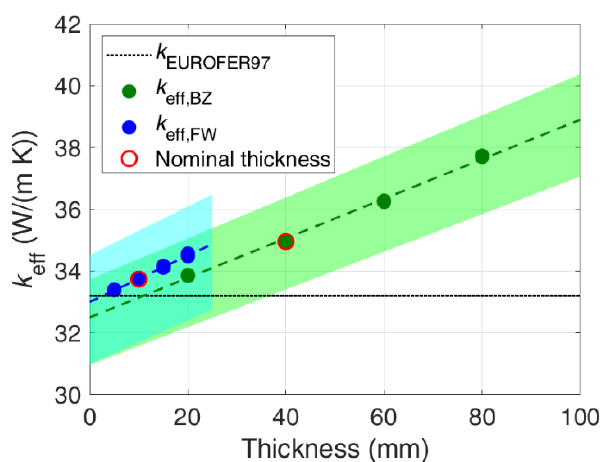
Figure 10. Computed values of the effective thermal conductivity as a function of the thickness; the fitting curves are also reported. The filled regions represent the relative variation of k eff when the convective heat transfer coefficient (HTC) varies by ±20%.